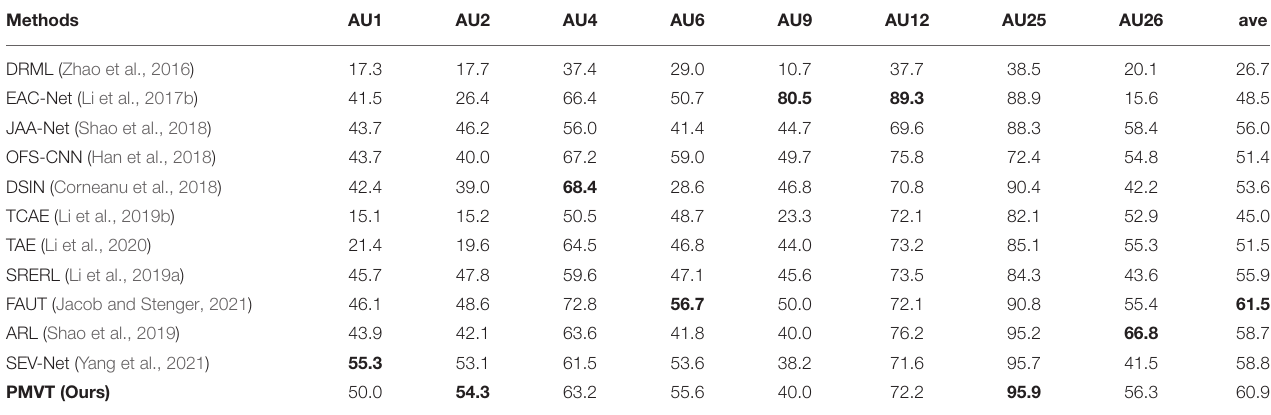
PMVT (Ours) The highest values are illustrated in Bold format.